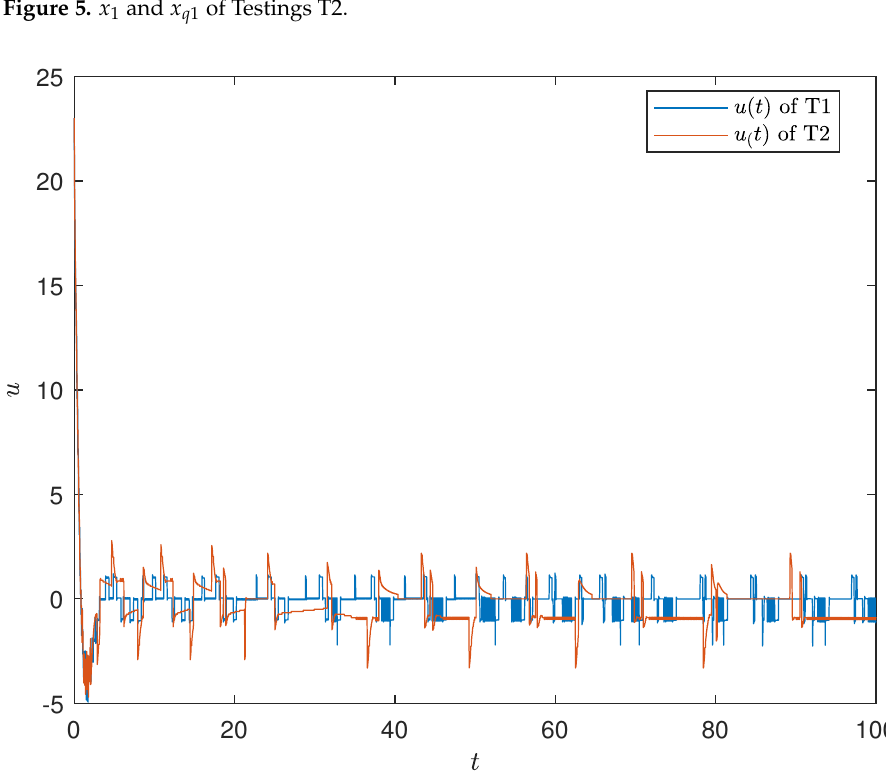
Figure 5. x 1 and x q 1 of Testings T2.